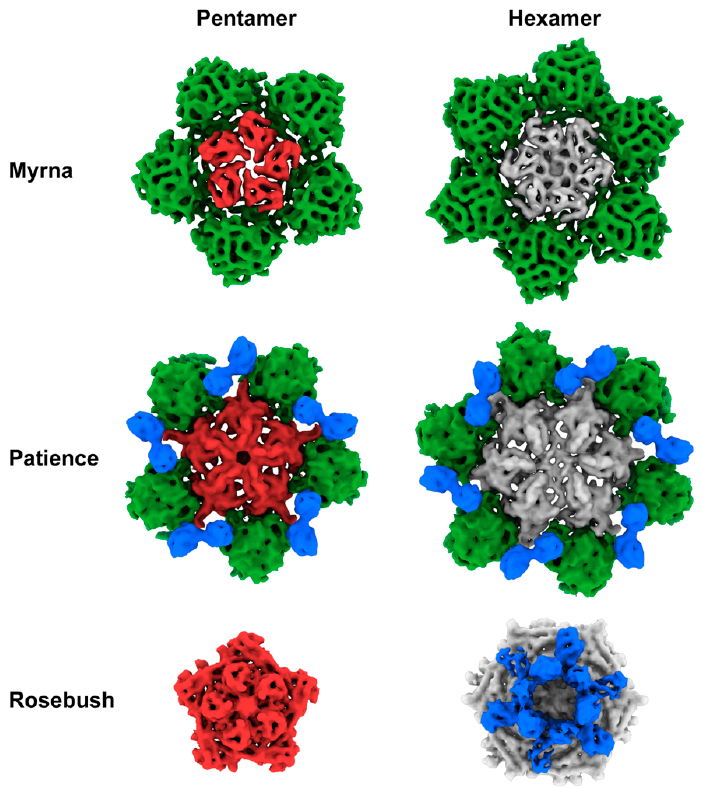
Figure 4. Hexamers and pentamers of the actinobacteriophages. The pentamers and hexamers (including minor/decoration proteins) have been segmented out from the capsid maps using the Segger [29] setting in Chimera [27]. Major capsid proteins are colored grey (hexamer) or red (pentamer). Minor capsid proteins green and decoration proteins blue. Images have not been re-scaled and are comparable.